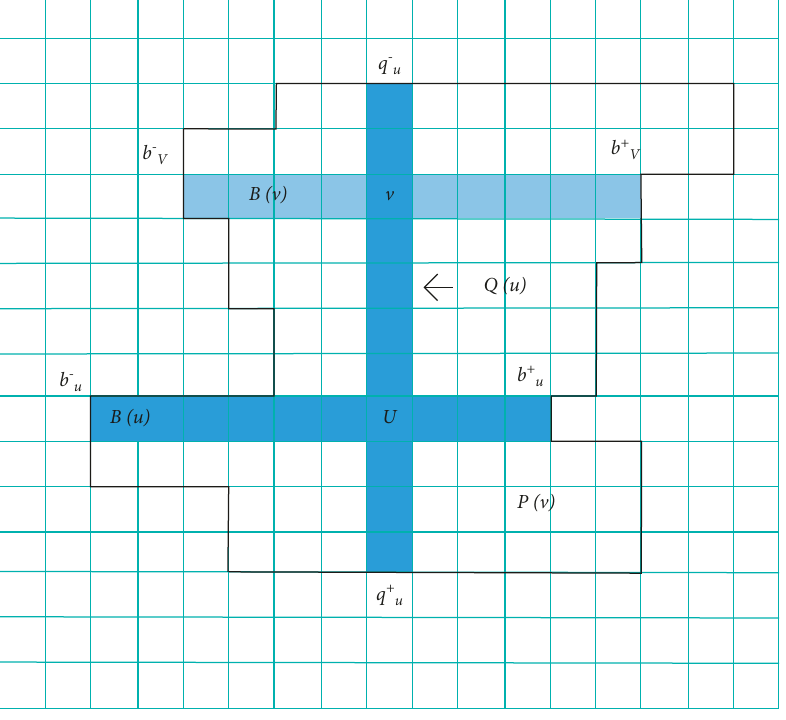
Figure 2: Window construction of cost aggregation